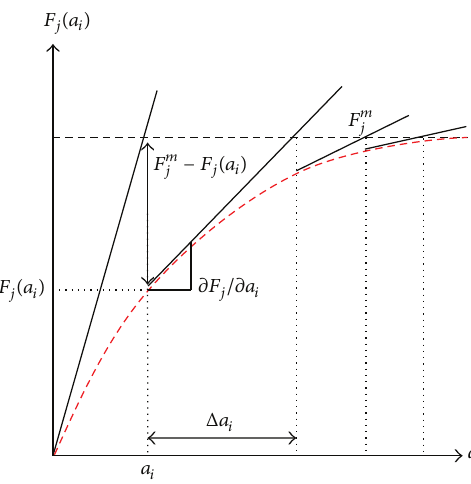
Figure 2: The iterative procedure for obtaining variable 𝑎 𝑖